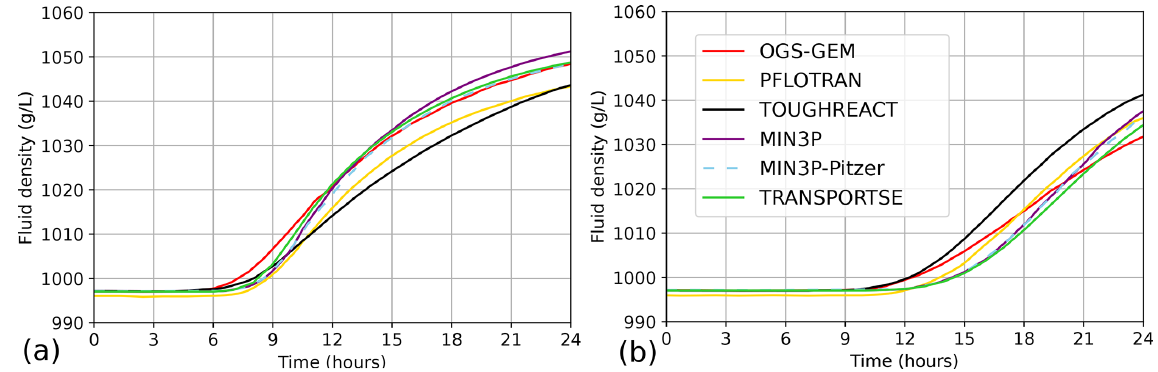
Figure 7. Fluid densities at observation points (a) c and (b) d at different times calculated by TRANSPORTSE-PHREEQC in comparison against the results documented by Poonoosamy et al. (2021).